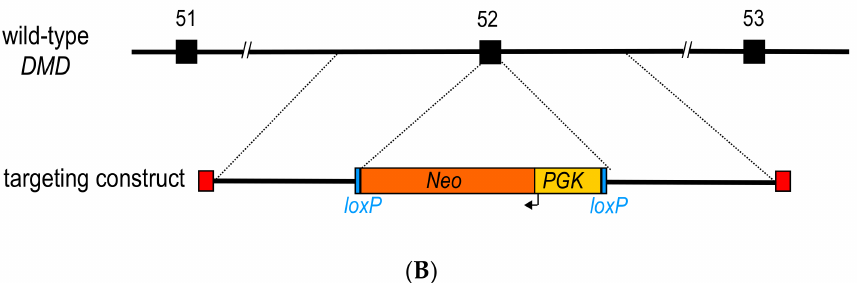
Figure 1. Overview of generation of the clonal miniature pigs with a DMD exon-52 deletion mutation. ( A ) Schematic of the combination method of the rAAV-mediated gene targeting and somatic cell nuclear transfer for producing the cloned DMD -targeted male piglets. Fibroblast cells derived from male pigs at the age of 35-days were obtained and infected with the rAAV packaging DMD ex52del targeted vector identified by a red asterisk. The DMD -targeted male pig fibroblast nucleus was transferred into enucleated oocytes, followed by fusion and activation in cells. The nuclear transfer (NT) embryos were transferred into the uterus of a recipient pig. After a 114 day gestation period, DMD -targeted piglets were produced. ( B ) Porcine DMD exon 52 was replaced with a neomycin resistance cassette ( Neo R ) (orange) driven by a phosphoglycerate kinase (PGK) promoter (yellow) and flanked by loxP sites (blue). Exons 51–53 of porcine DMD are depicted in black boxes. The rAAV inverted terminal repeats (ITRs) are in red. Each homology arm is ~1.4 kb in length. The figure is not to scale.